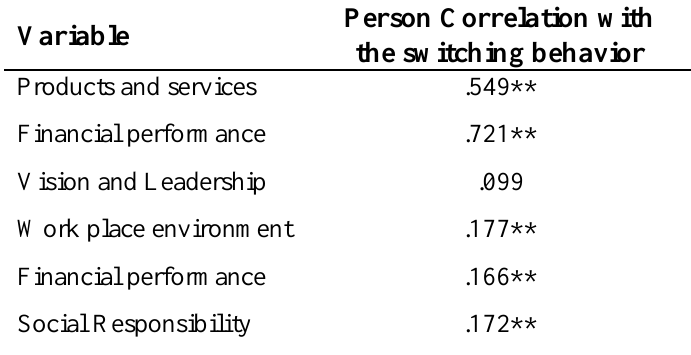
Table 05: Correlation between variables under corporate reputation and switching